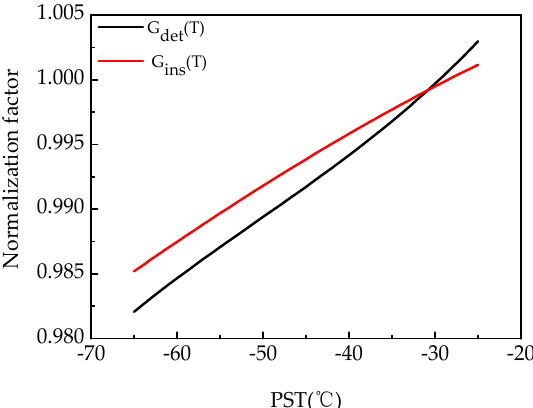
Figure 17. Comparison between the detector-level and instrument-level experimental results. G det (T) shows nonlinear change with PST, and the relative change in responsivity is greater compared with G ins (T). This difference may be that the detectors used in the two experiments were not from the same batch of products. Using G det (T) to correct changes in PSAC responsivity within a large temperature range may cause deviation.